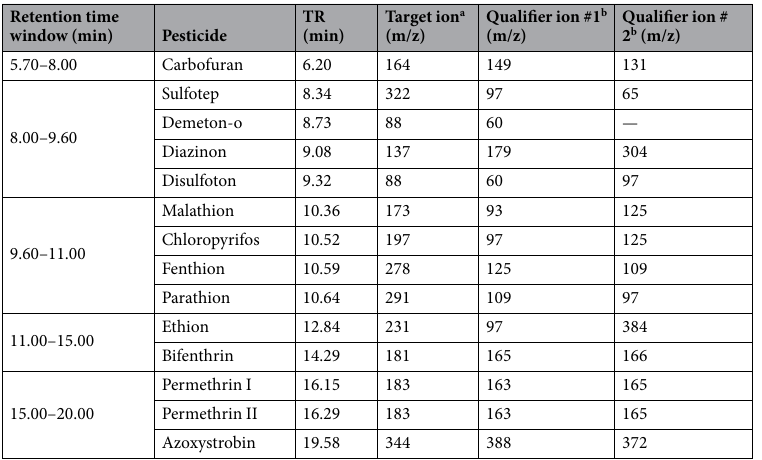
Table 1. Parameters of GC-MS analysis in SIM mode for the selected pesticides. a ion base, used for quantification purposes; b reference ions, used for improving pesticide